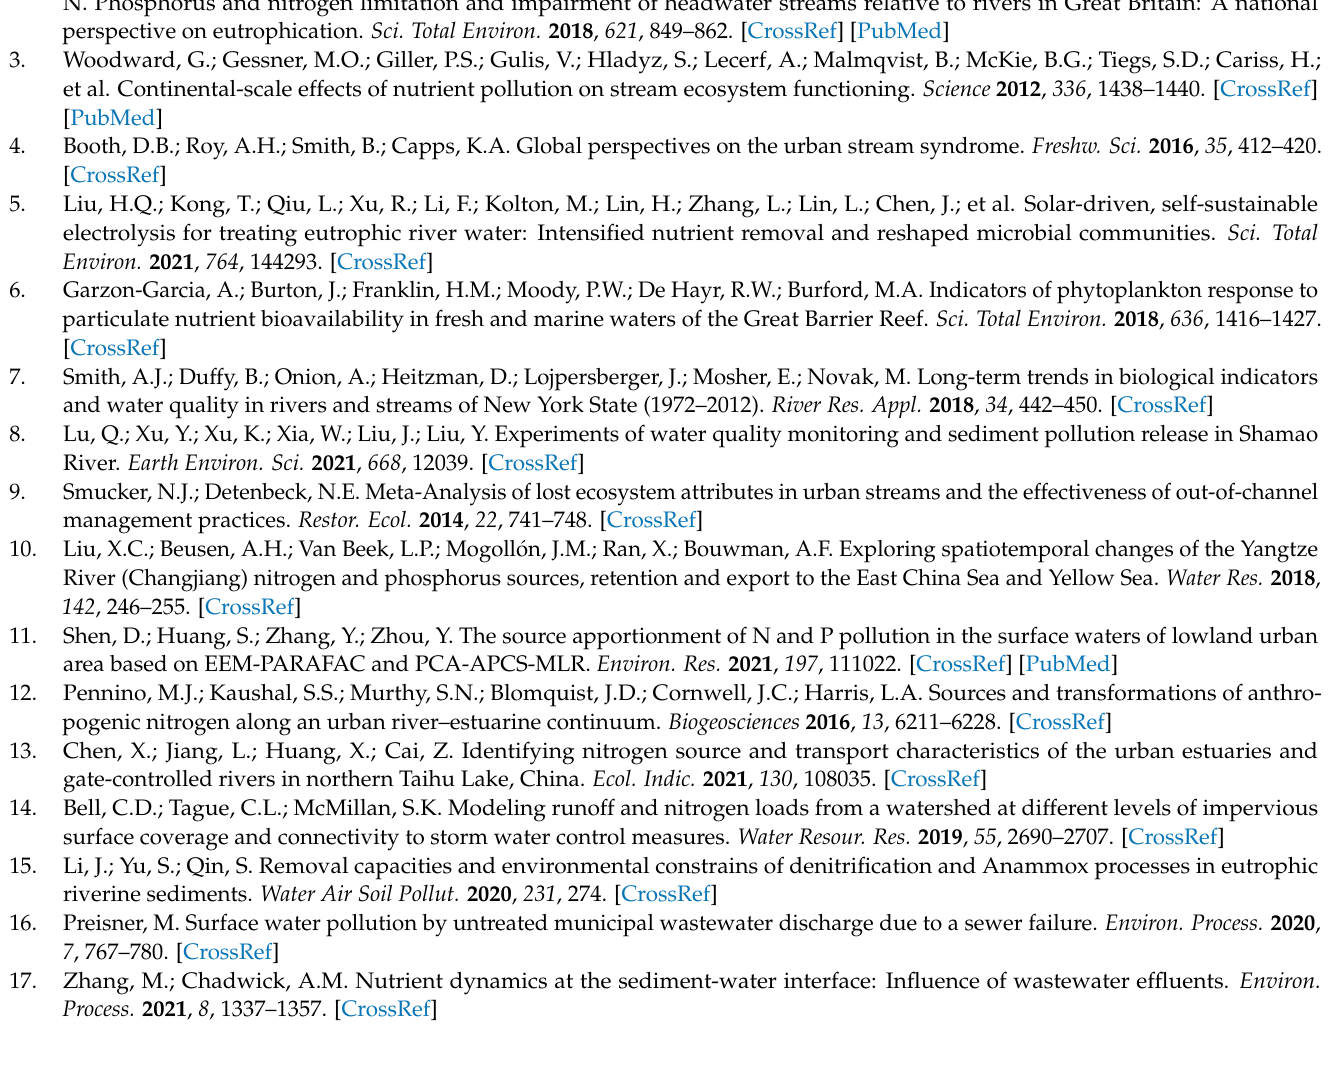
Table S8b: SEM fitting indexes; Table S9: Sediment condition summary; Table S10: The concentration of nutrients with the equilibrium flux at the sediment-water interface